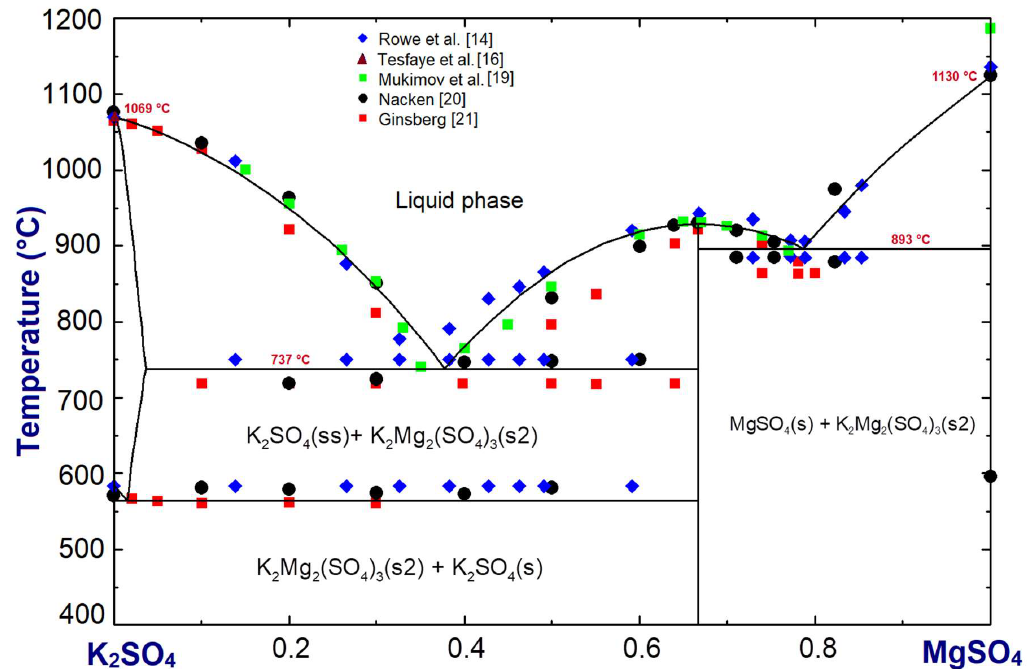
Figure 4. K 2 SO 4 -MgSO 4 system optimized using the FactSage software package. Compositions are in mole fraction; (ss) indicates solid solution.